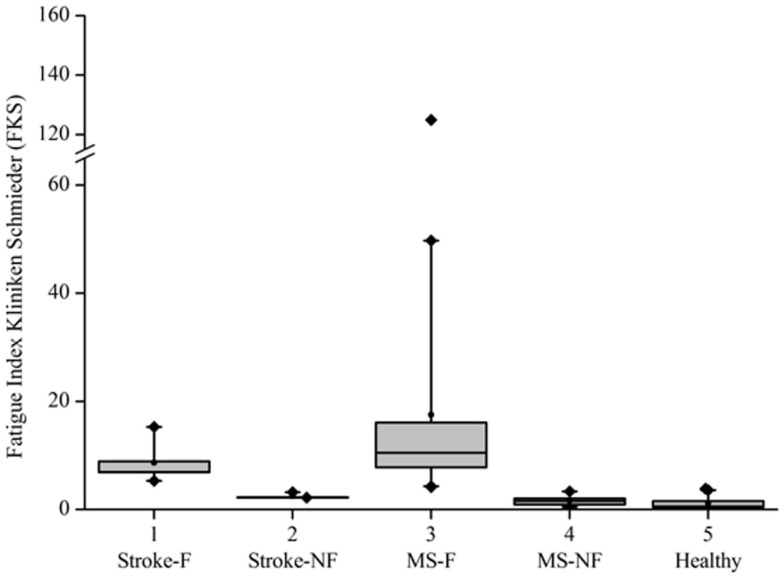
Boxplot for FKS values in all groups.